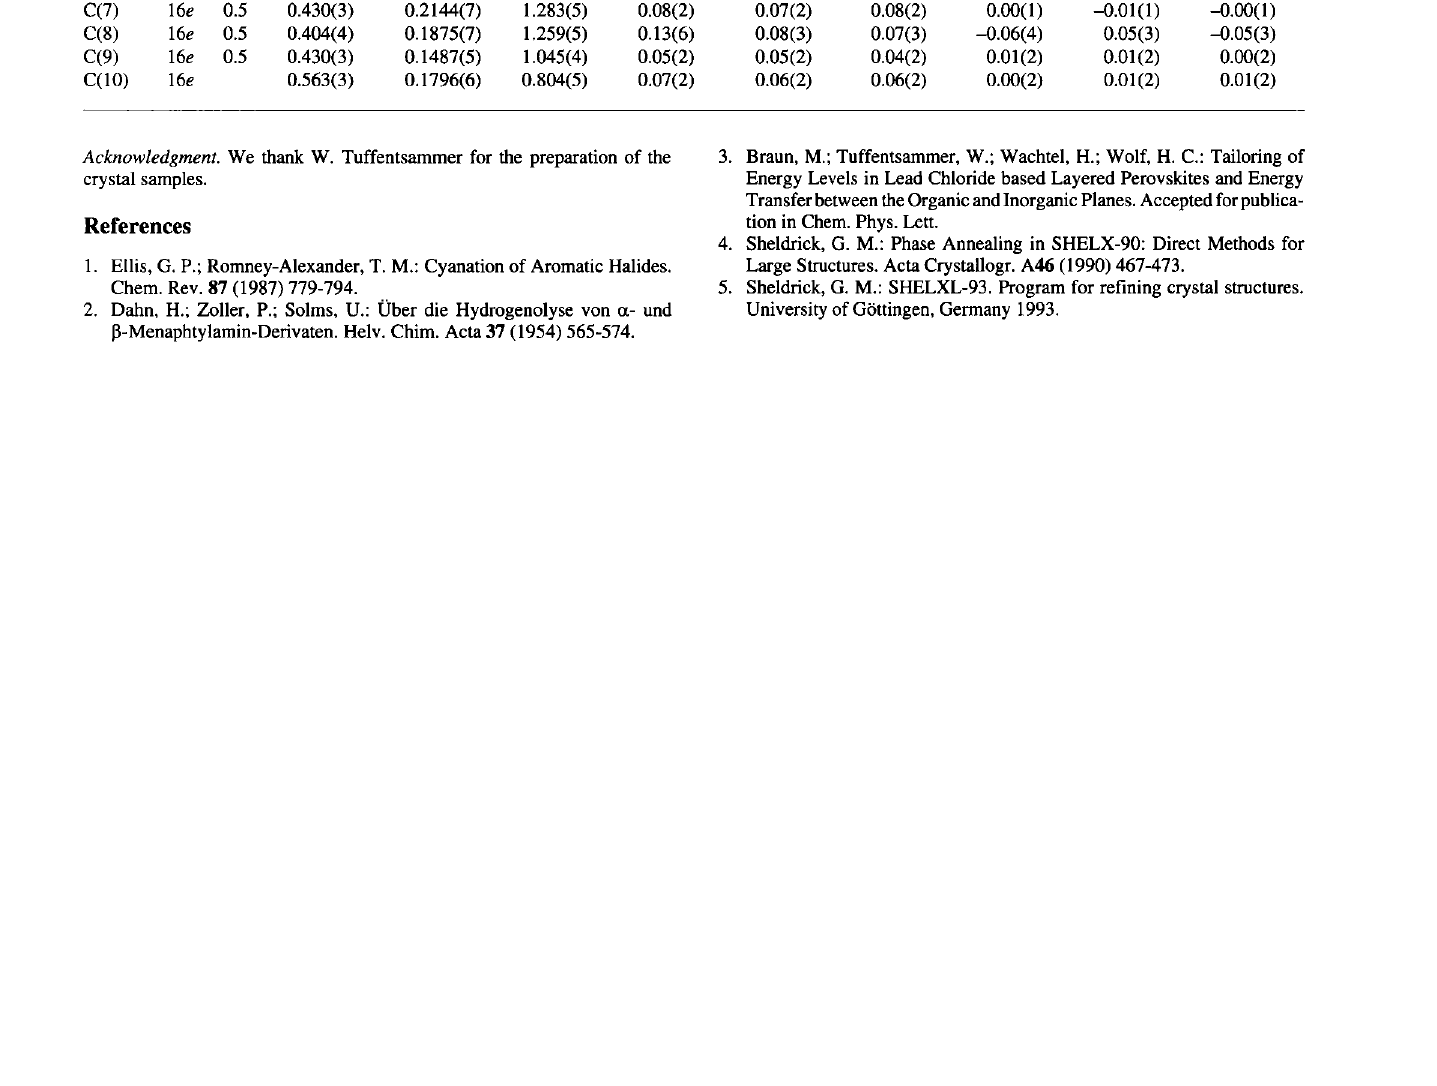
Table 3. Atomic coordinates and displacement parameters (in Â 2